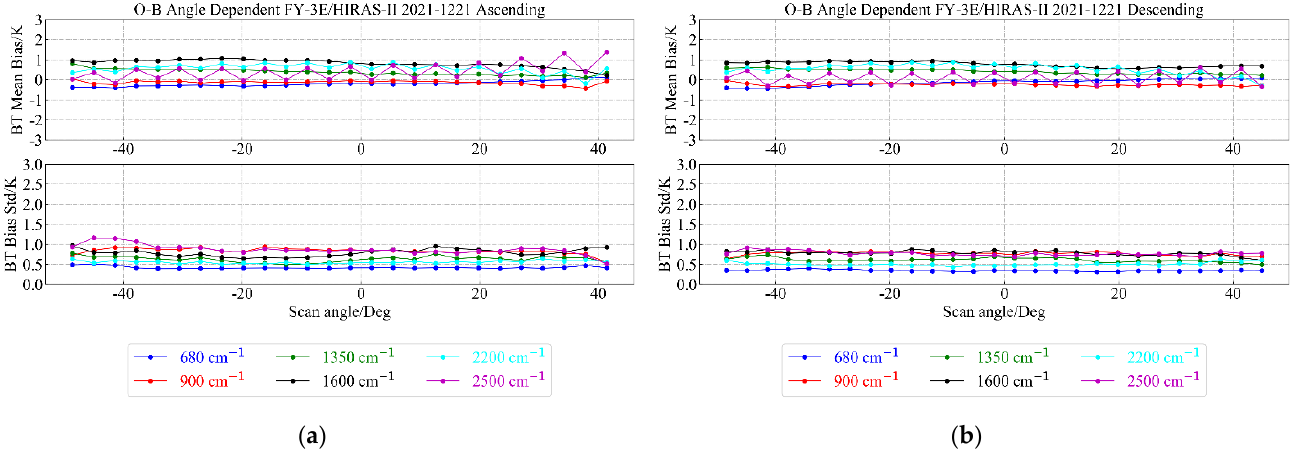
Figure 22. The distribution of the bias of a typical channel with the scanning angle: ( a ) the ascending orbit samples; ( b ) the descending orbit samples.